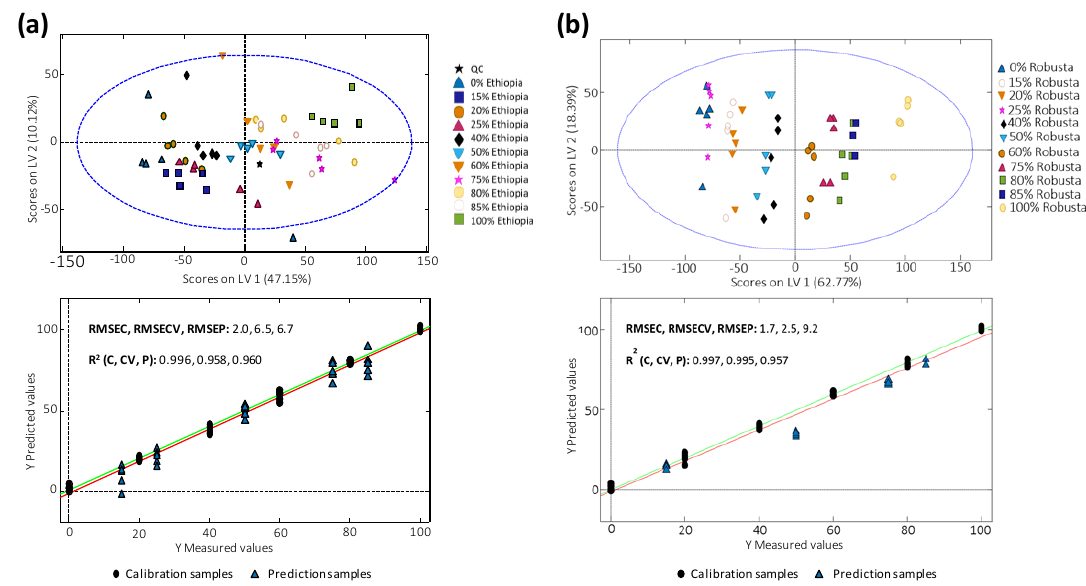
Figure 6. LV1 vs. LV2 score plot of both calibration and validation sets by PLSR for ( a ) Colombian coffee adulterated with Ethiopian coffee and ( b ) Vietnamese Arabica coffee adulterated with Vietnamese Robusta coffee. Models ( a , b ) were created with 6 and 4 LVs, respectively.